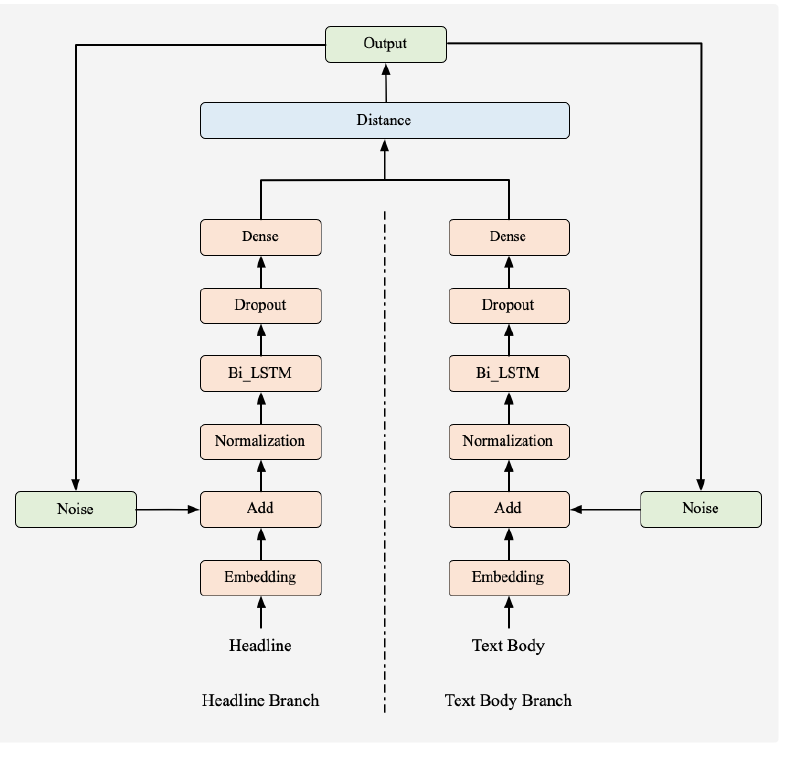
Figure 2. Model architecture. Table 1. Symbols in this